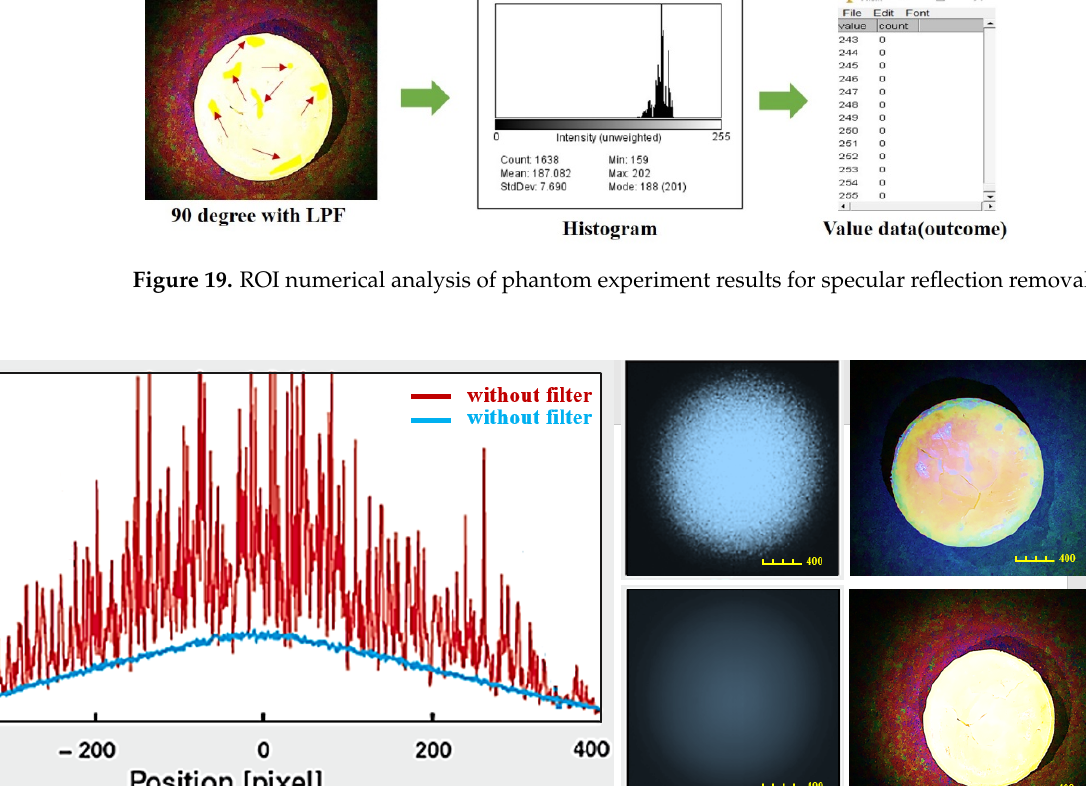
Figure 20. Image test results of speckle noise contrast for light reflection removal through the Figure 19.